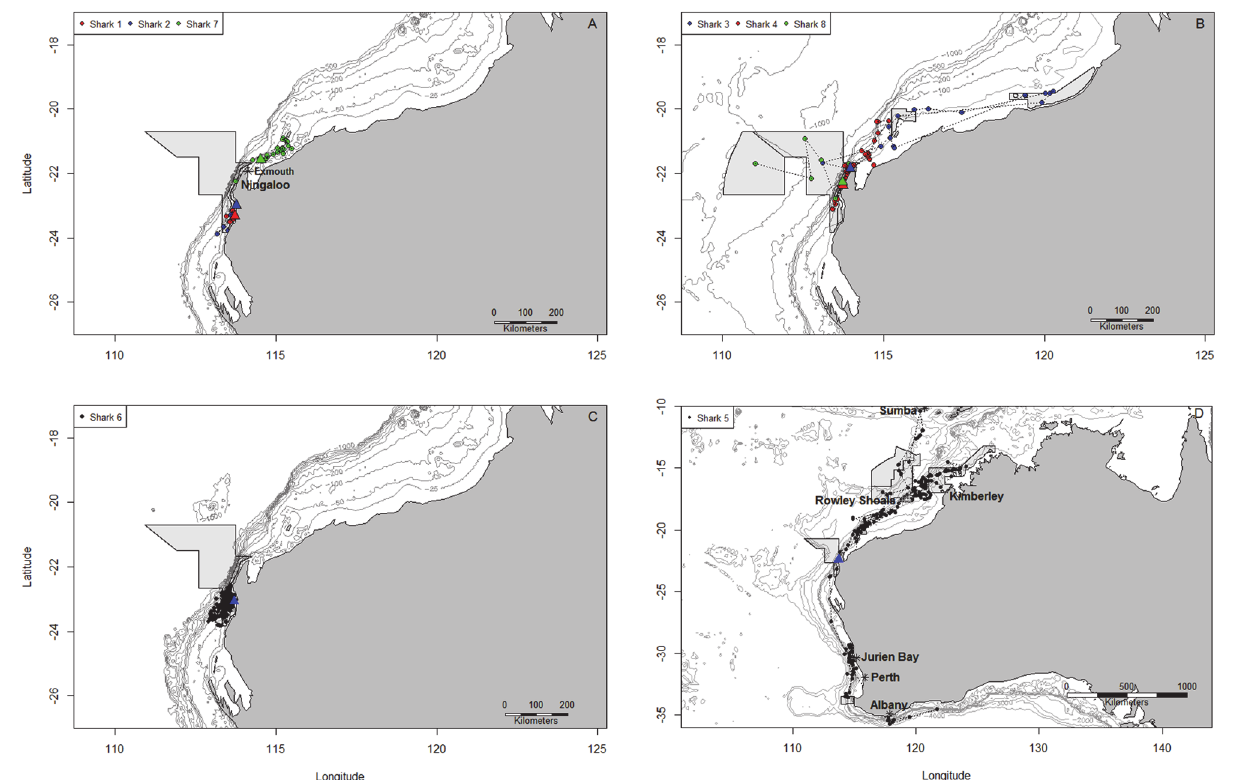
Fig 1. Movement patterns of tiger sharks in Western Australia. Maps show location uplinks of 8 tiger sharks. Triangles indicate tagging location and grey polygons indicate Commonwealth Marine